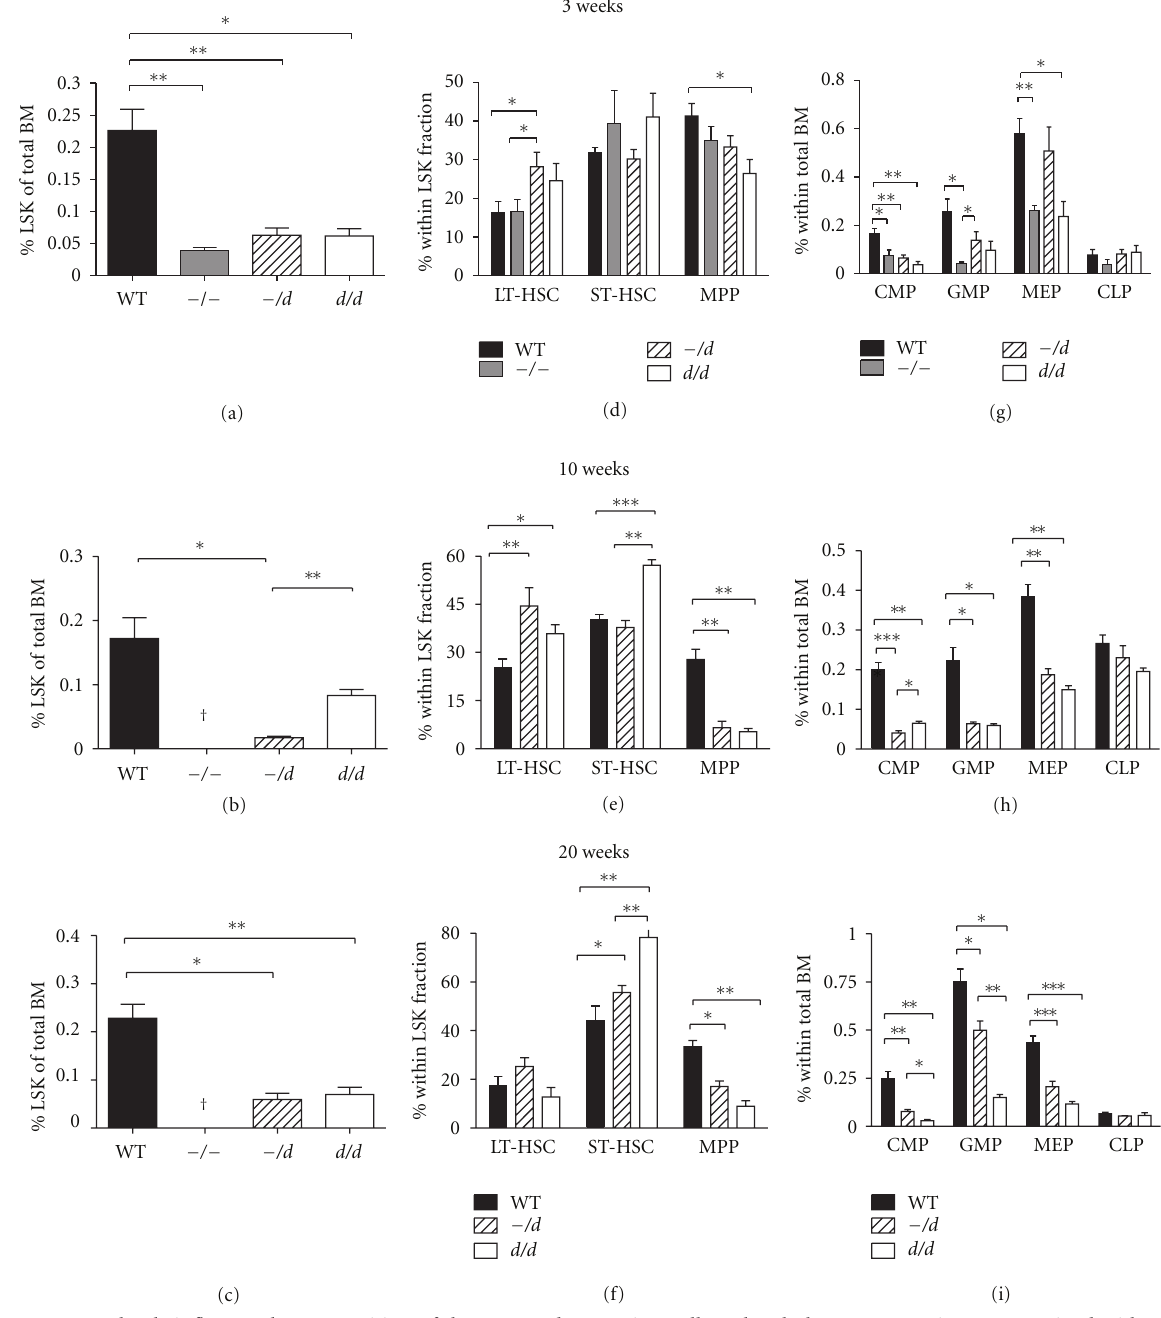
Figure 3: Ercc1 levels influence the composition of the stem and progenitor cell pool. Whole BM suspensions were stained with surface antigen specific antibodies for hematopoietic stem cells. ((a)–(c)) LSK (Lin − Sca1+ cKit+) cells as percentage of total bone marrow cells. ((d)–(f)) Distribution of stem cells within the LSK fraction (LT HSC(CD34 − CD135 − ), ST-HSC (CD34+ CD135 − ) and MPP (CD34+ CD135+)). ((g)–(i)) Distribution of progenitor cells within total bone marrow (CMP (Lin − cKit+ CD34+ CD16/CD32intermediate), GMP (Lin − cKit+ CD34+ CD16/CD32high), MEP (Lin − cKit+ CD34 − CD16/CD32low) and CLP (Lin − CD127+ Sca1/cKit intermediate)). Mean percentages are plotted; error bars indicate standard deviation. ∗ indicates P ≤ 0 . 05, ∗∗ indicates P ≤ 0 . 01 and ∗∗∗ indicates P ≤ 0 .